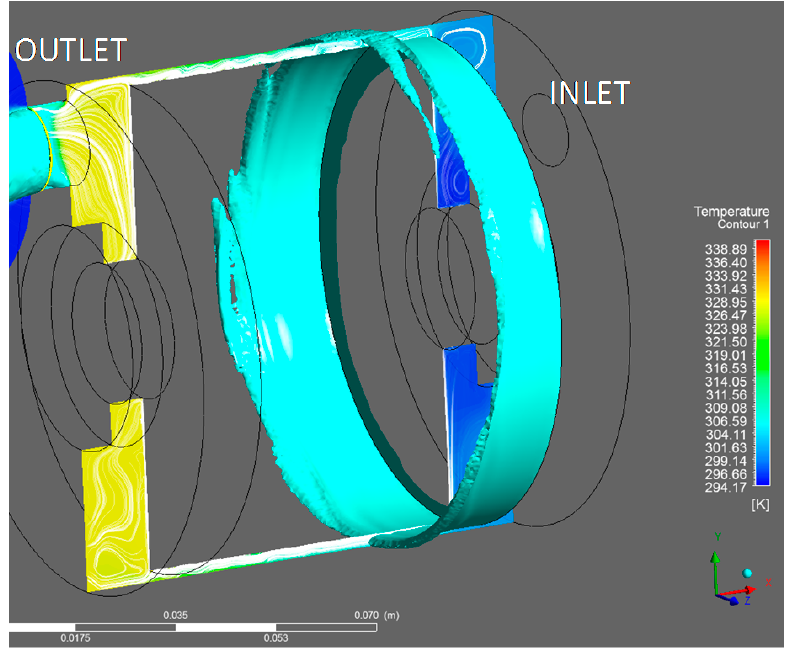
Figure 16. CFD isotherms and streamlines.